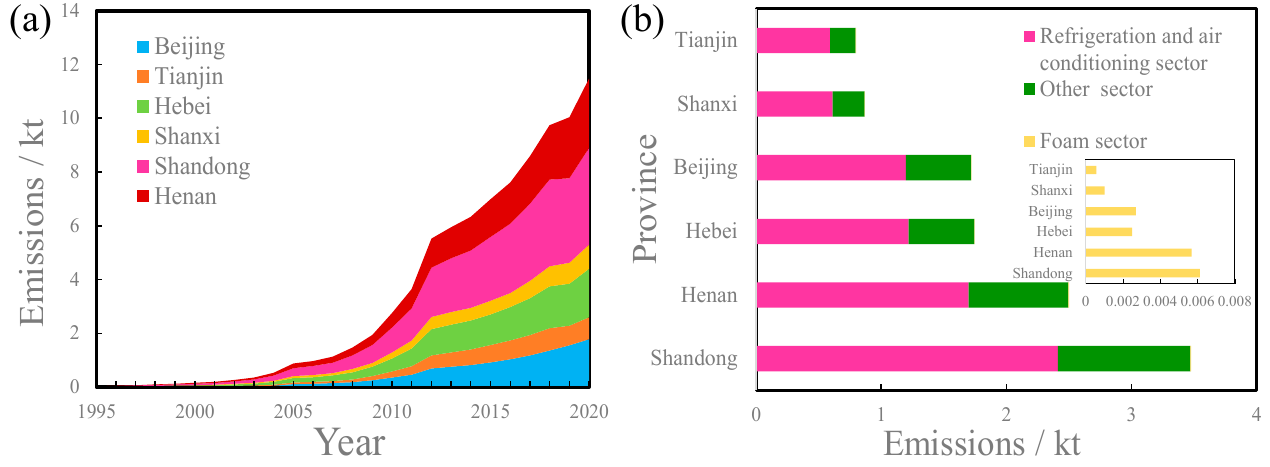
Figure 3. The annual and cumulative emissions from 1995 to 2020 depicting ( a ) annual emissions by province and ( b ) cumulative emissions by province and sector.